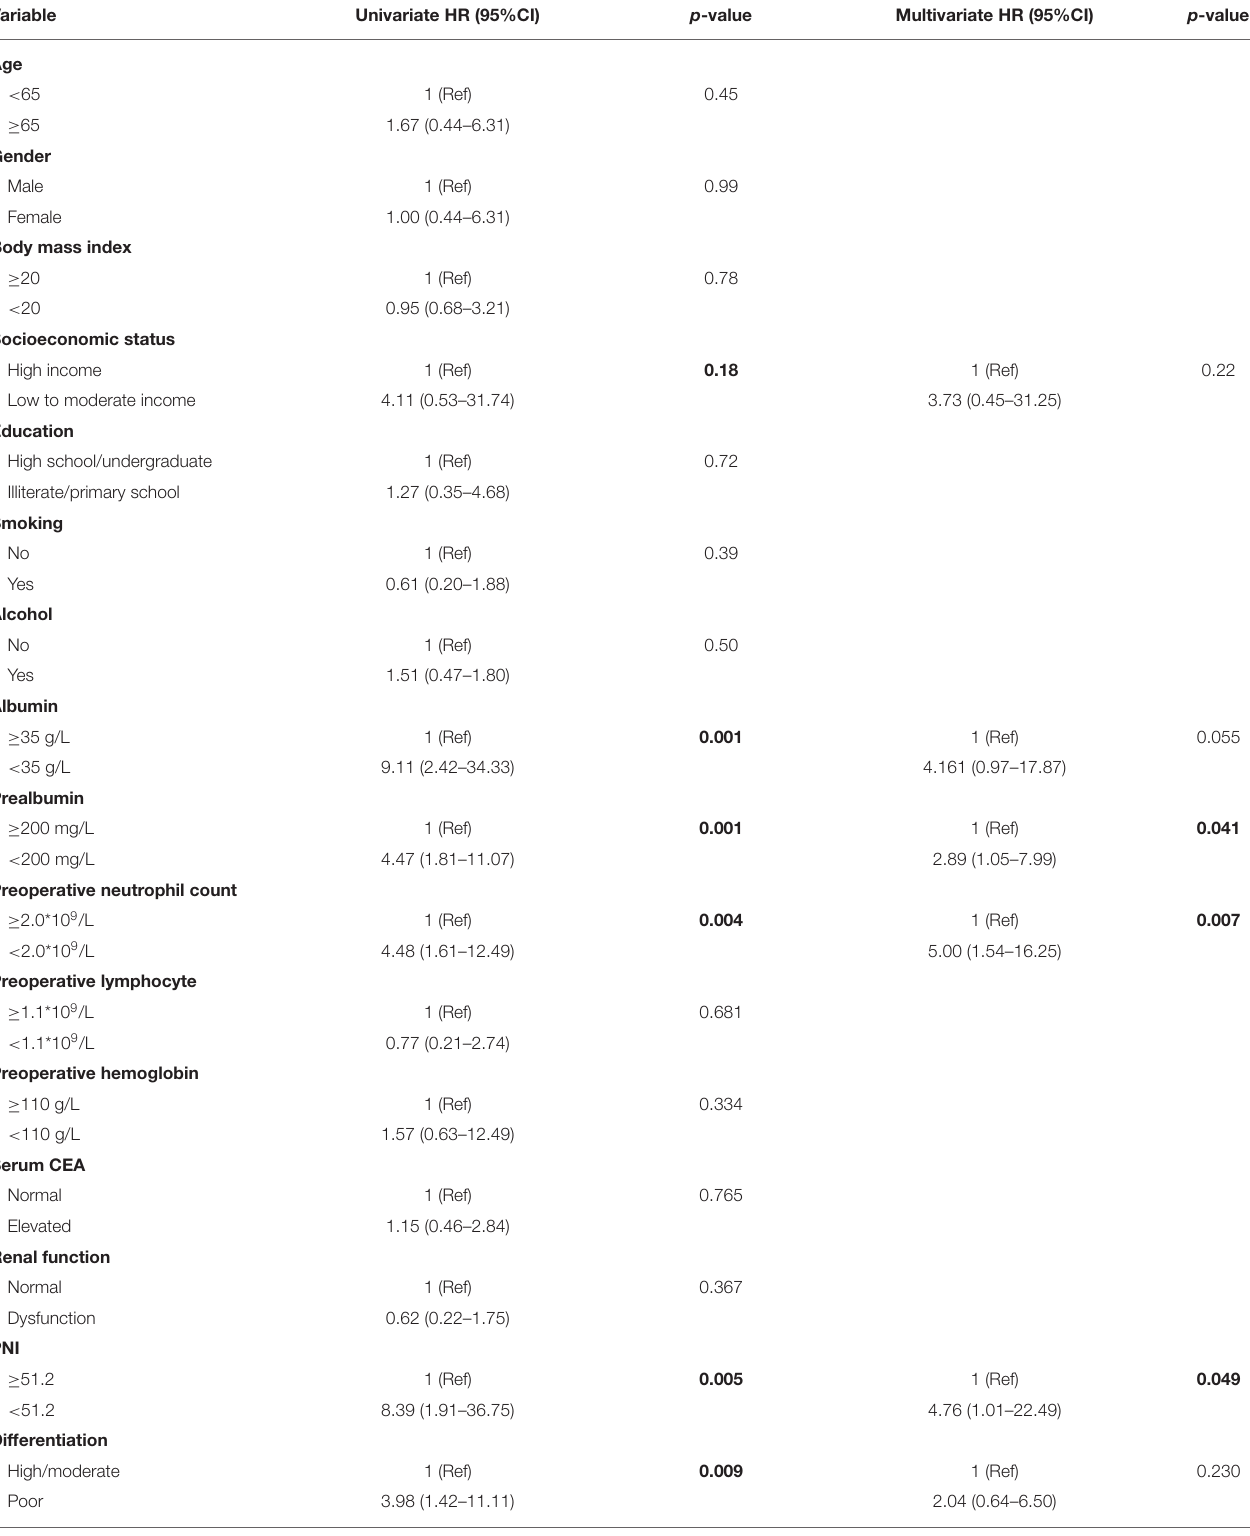
TABLE 2 | Univariate and multivariate analysis for factors